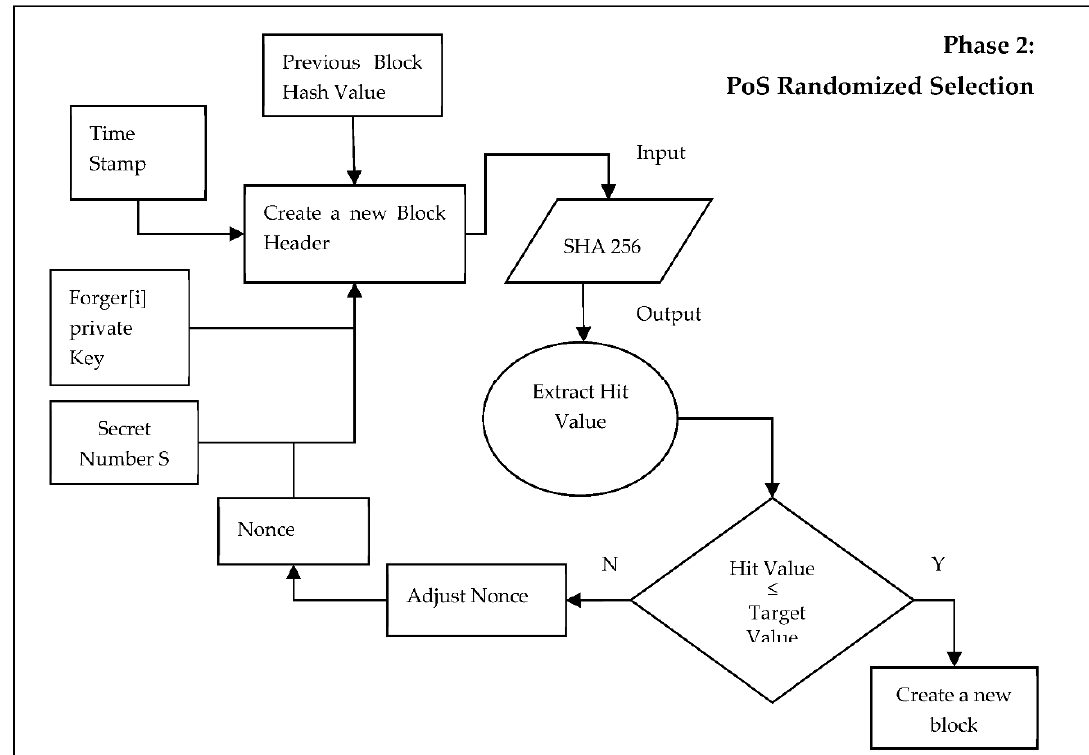
Figure 5. Proposed consensus algorithm (Phase 2).